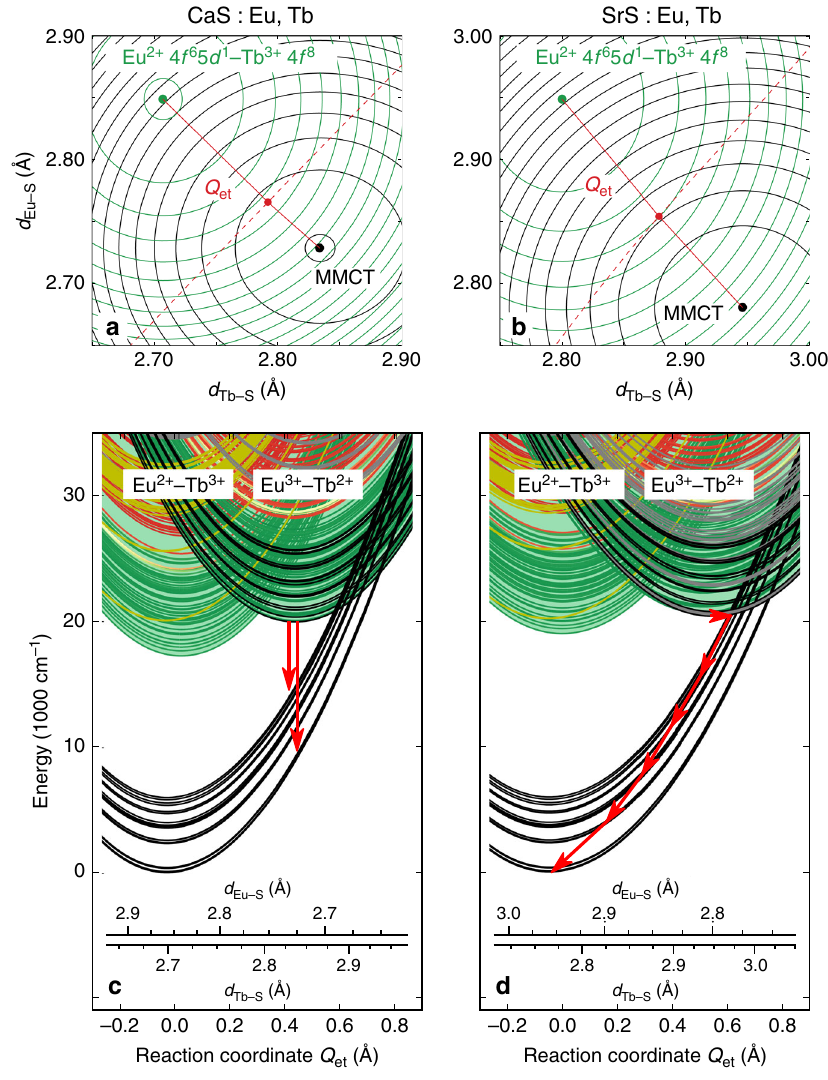
Fig. 6 Metal-to-metal charge transfer many-electron diagrams. Contour plots of selected potential energy surfaces in the two-dimensional con fi gurational space ( d Eu – S , d Tb – S ) ( a , b ) and con fi gurational coordinate diagrams along the electron transfer reaction coordinate ( Q et ) ( c , d ) for Eu – Tb pairs in CaS ( a , c ) and SrS ( b , d ). The con fi gurational coordinate diagrams display the following levels for the Eu 2 + – Tb 3 + con fi guration: 4 f 7 ( 8 S ) – 4 f 8 ( 7 F ) (cid:4) 4 f 8 ð 1 A Þ (green for high-spin states, red for low-spin states) and 4 f 7 ( 8 S ) – 4 f 8 ( 5 D , L , G ) (gold), and following levels for the Eu 3 + – Tb 2 + (black), 4 f 6 5 dt 1 1 g 2 g con fi guration: 4 f 6 ( 7 F ) – 4 f 8 5 d 1 (1 Γ 7 g ) (black), 4 f 6 (1 A 1 g ) – 4 f 8 5 dt 2 g (green for high-spin states, red for low-spin states), and 4 f 6 (1 A 1 g ) – 4 f 9 (gray). The quasi- continuum formed by all other levels of the Eu – Tb pair, where none of both ions is in its ground state are represented by the green-colored background. The contour plots display the isolines corresponding to the Eu 2 + 4 f 6 5 d 1 (1 Γ 8 g ) – Tb 3 + 4 f 8 (1 A 1 g ) and Eu 3 + 4 f 6 ( 7 F ) – Tb 2 + 4 f 8 5 d 1 (1 Γ 7 g ) (lowest metal-to-metal charge transfer (MMCT) state) surfaces. The reaction coordinate is indicated in red, along with the intersection between both surfaces (dashed red